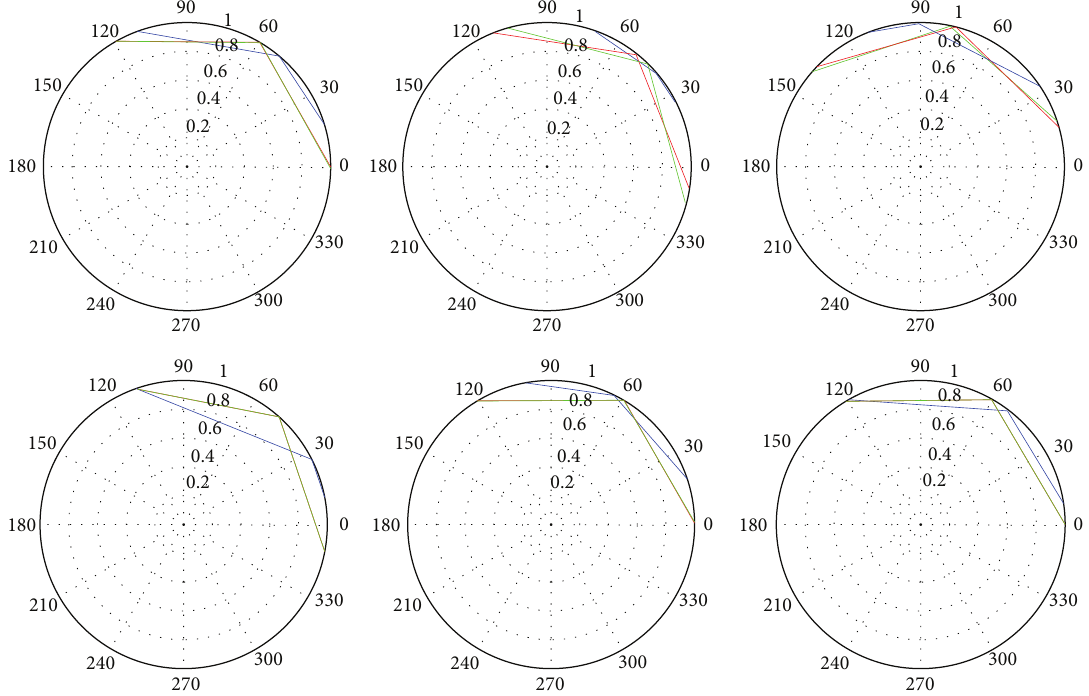
Figure 2: Original frame {𝑇 𝑗 } 3 𝑗= 1 in blue, optimal frame {𝑍 𝑗 } 3 𝑗= 1 = {𝑈 ̂𝜃 𝑌 𝑗 } 3 𝑗= 1 in green, and our proposed algorithm finds {Γ 1 / 2 𝑇 𝑗 /‖Γ 1 / 2 𝑇 𝑗 ‖} 3 𝑗= 1 in red. (Green and red lines are sometimes right on top of each other.)